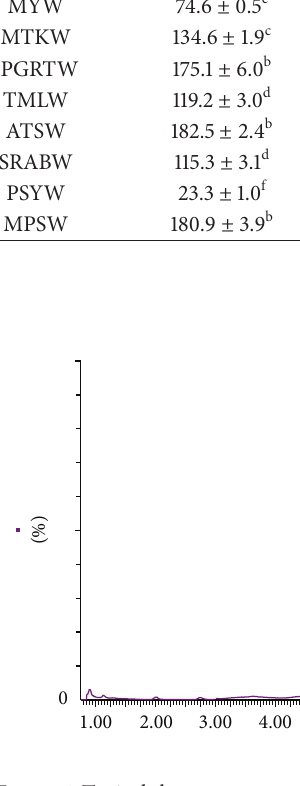
Figure1:Typicalchromatogramofthenonanthocyanidinphenolics in pomegranate juice (MYW) as detected by MS in selected ion monitoring (SIM) mode. Punicalagins appear as doubly charged ions. Ions with m/z = 301 other than ellagic acid are in-source fragments of other